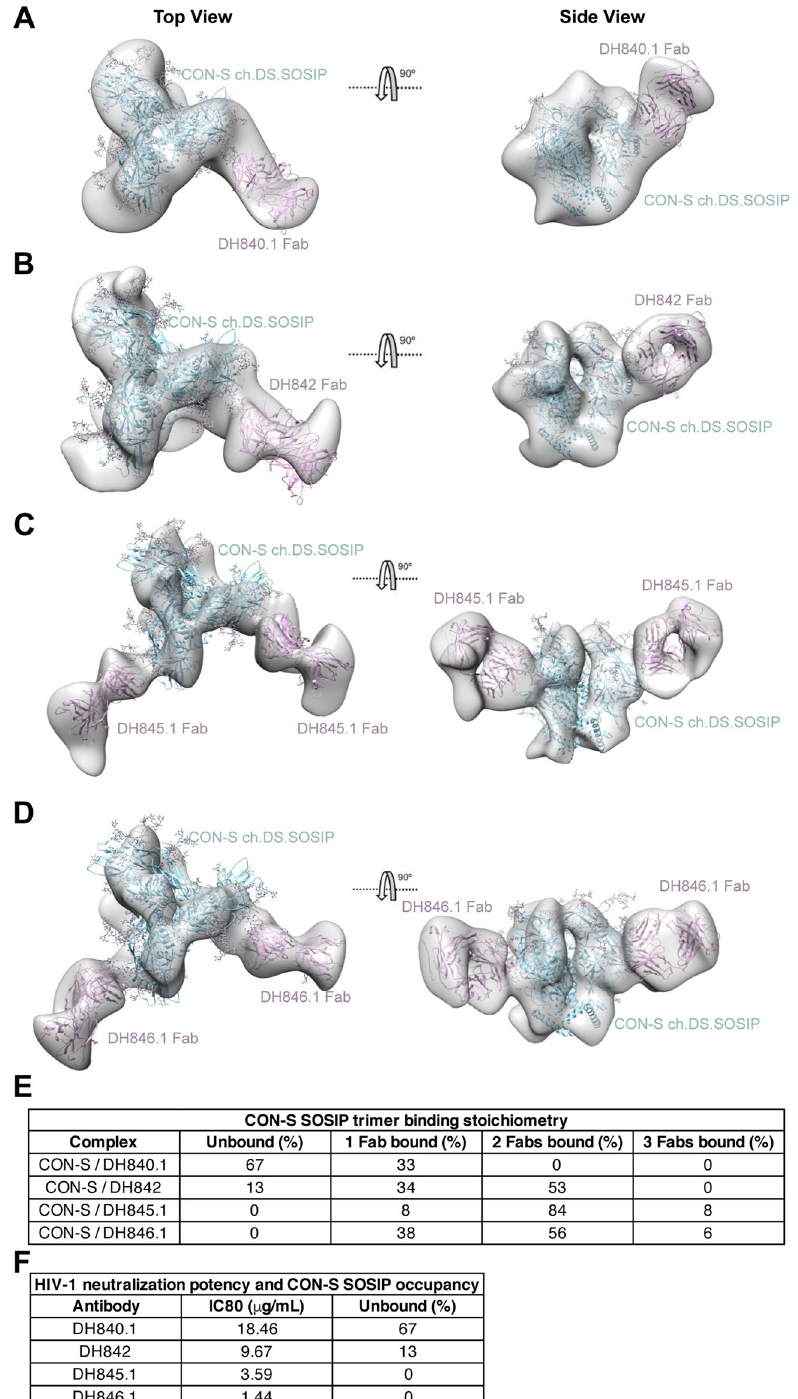
Fig 4. Vaccine-induced CON-S antibodies bind to the outer domain of HIV-1 gp120 near the third constant and fifth variable regions with similar angles of approach. (A-D) Top and side views of the final 3D reconstructions of the stabilized soluble CON-S envelope trimer bound to (A) DH840.1, (B) DH842, (C) DH845.1 and (D) DH846.1. The 3D volumes are in solid gray with BG505 SOSIP.664 (PDB:4NCO; blue) and Fab (pink) fitted into the density. (E) Stoichiometry of Fabs bound to CON-S Env trimer observed by negative stain electron microscopy. (F) Comparison of CON-S neutralization potency, shown as the concentration ( μ g/mL) of antibody that inhibits 80% of virus replication